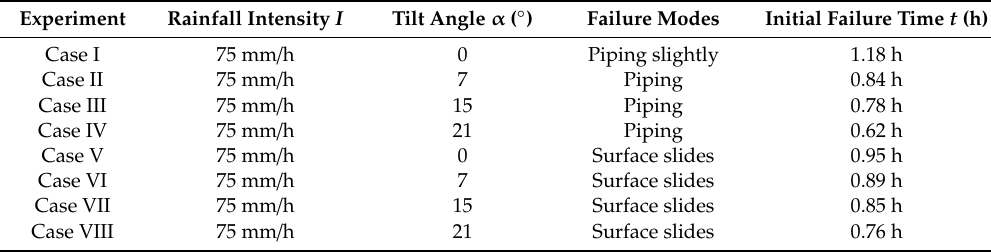
Table 4. Failure conditions of physical model